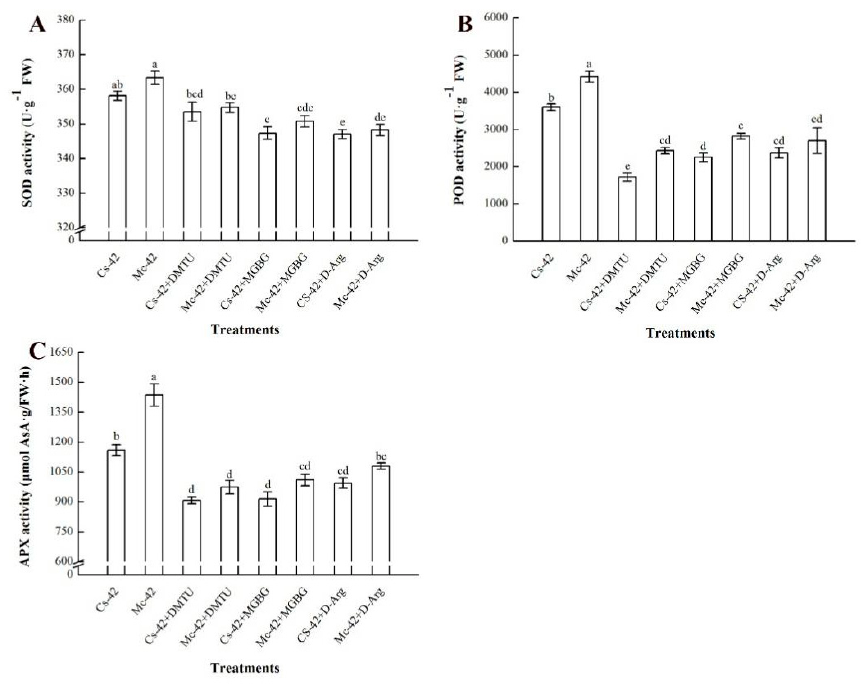
Figure 7. E ff ects of polyamine synthesis inhibitors D-arginine (D-Arg) and methylglyoxal bis-guanylhydrazone (MGBG) and an H 2 O 2 scavenger (DMTU) on enzyme activity of ( A ) Superoxide dismutase (SOD), ( B ) Peroxidase (POD), and ( C ) Ascorbate peroxidase (APX) in grafted cucumber leaves under heat stress conditions. Self-grafted plants treated with 42 ◦ C / 32 ◦ C (day / night), Cs-42; bitter-melon-grafted plants treated with 42 ◦ C / 32 ◦ C (day / night), Mc-42. All inhibitors were sprayed 12 h before exposure to heat stress. Seedlings were treated for 24 h under heat stress conditions. Bars represent the mean ± SE of at least three independent experiments. The di ff erent letters indicate significant di ff erences at p < 0.05 according to Duncan’s multiple range test.